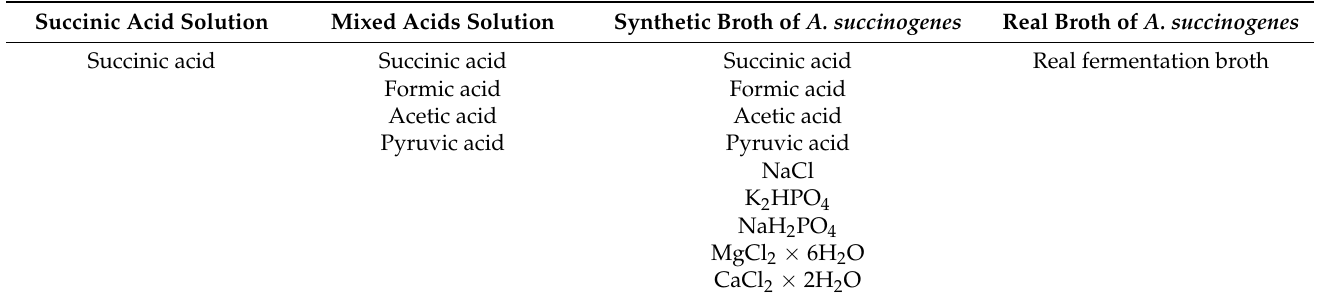
Table 1. Qualitative composition of the different types of organic acid solutions used in the experiments. The concentrations are not indicated in this table because they varied throughout the